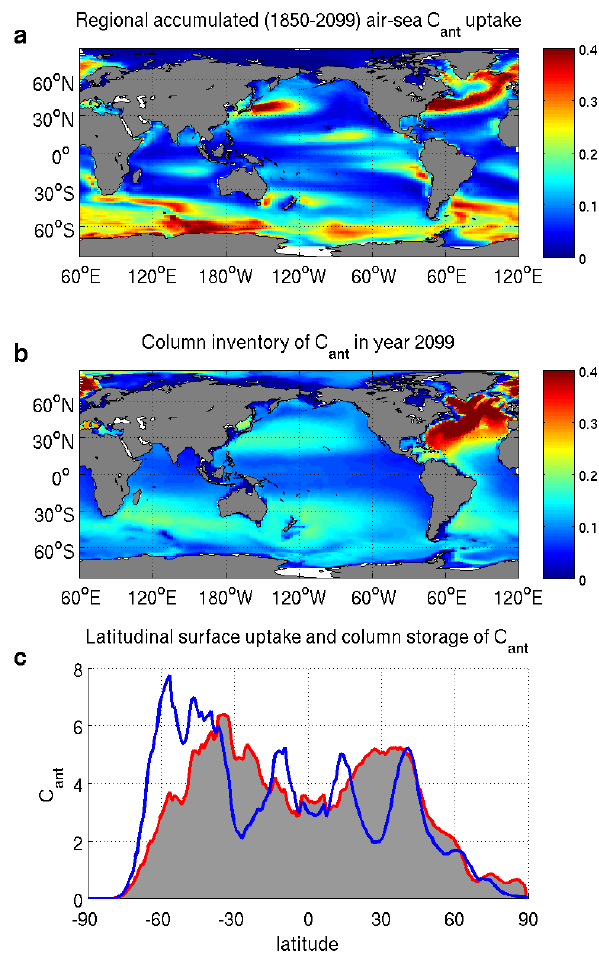
Fig. 2. Spatial distribution of (a) accumulated (1850–2099) C ant uptake across the air-sea interface (kmolCm − 2 ), (b) column in- ventory of C ant at the end of experiment period (kmolCm − 2 ), and (c) latitudinal distribution of total uptake (blue-line) and storage (grey shading) of C ant (PgCdeg − 1 ), also at the end of experiment